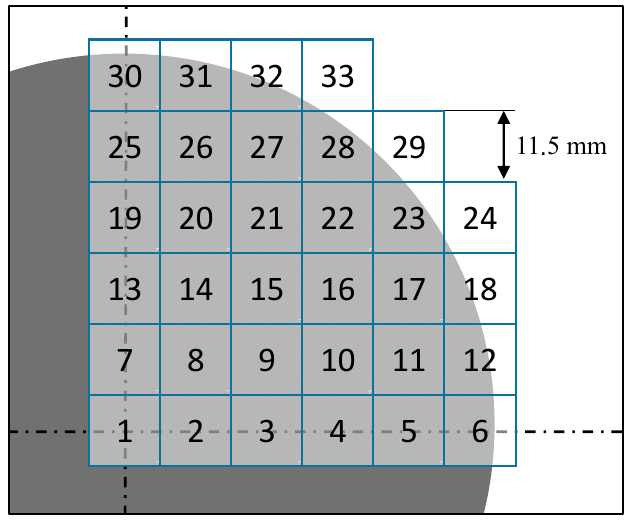
Figure 8. Segmentation of fiber ‐ reinforced discs for fiber content analysis.